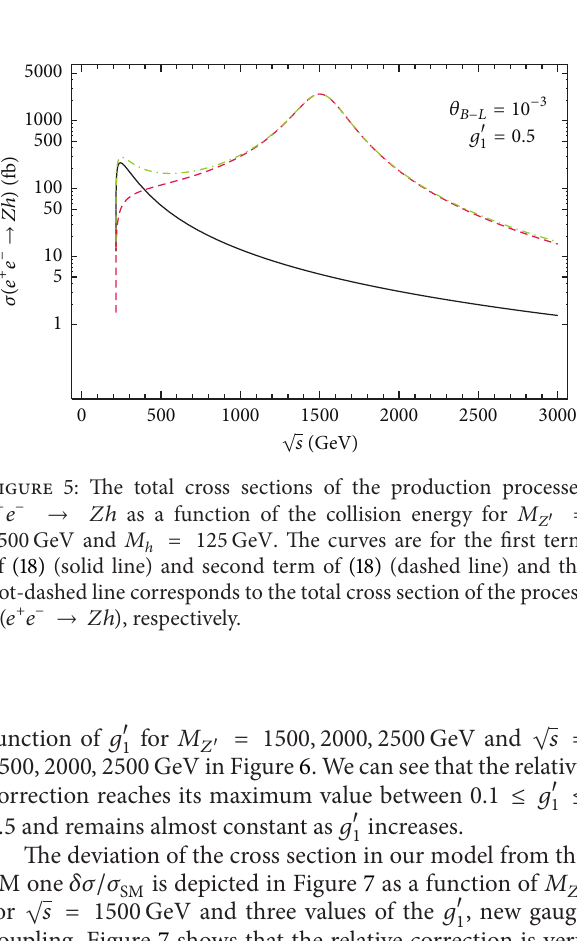
Figure 4: Branching ratios as a function of 𝑀 𝑍 󸀠 . Starting from the top, the curves are for the BR (𝑓𝑓) , BR (𝑍ℎ) , and BR (𝑊 + 𝑊 − ) , respectively.